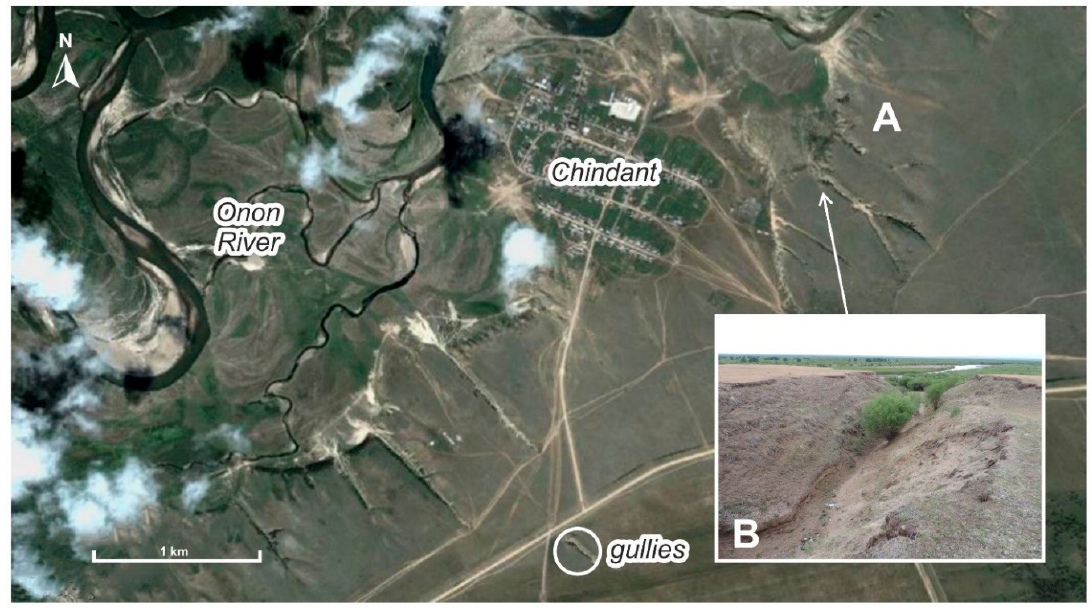
Figure 7. Stretch of the Onon river valley. Coordinates: 50033 (cid:48) 44.29” N; 115023 (cid:48) 32.13” E. The terrace cut with gullies ( A ). The image was taken on 8 March 2019. ( B ) Image of the gully (taken on 16 August 2015), its location is shown with the arrow.